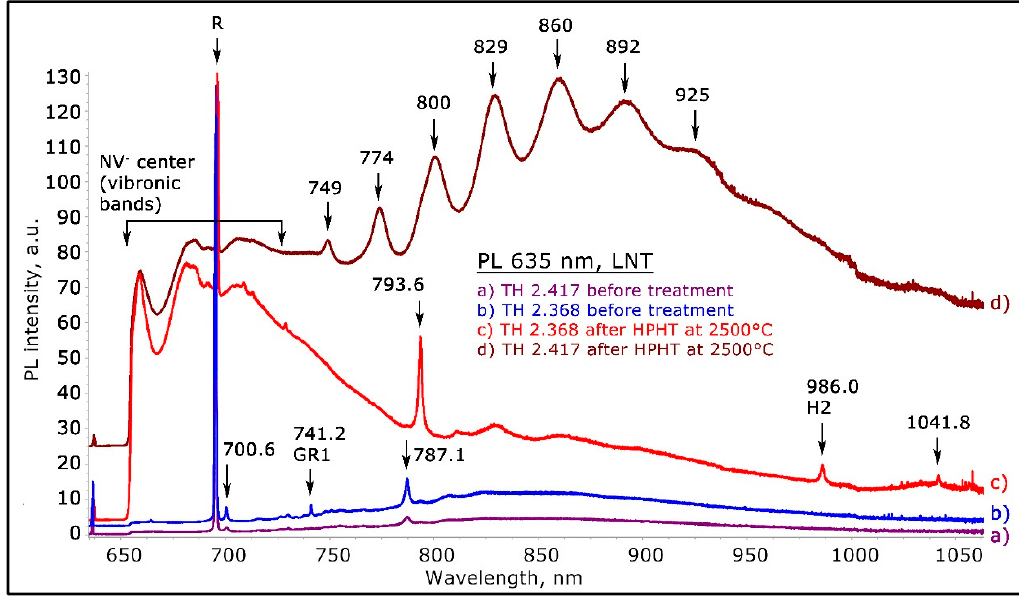
Figure 31. The low temperature PL spectra of two cape type IaAB diamonds that were HPHT processed at 2500 °C, excited by 635 nm laser. Sample TH 2.417 was light yellow before the treatment and turned orangey brown by HPHT while sample TH 2.368 was perfectly colorless before the treatment and turned vivid yellow by HPHT. While both spectra show the formation of significant NV- center post HPHT annealing, the formation of significant PL with rather broad bands every 25 to 33 nm in the more yellow diamond TH 2.417 is significant. This PL feature is published here for the first time and seems related to the defect formed by annealing the N3 center. The spectra have been shifted vertically for clarity.